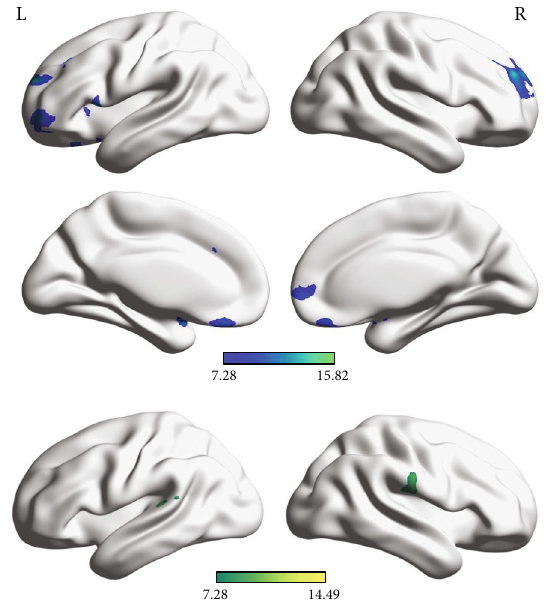
Figure 2: GMV alteration among BD, SZ, and HC. Signi fi cant at p < 0 : 05 with voxel p < 0 : 001 (GRF correction). Blue colour indicates relatively lower GMVs values in both BD and SZ. Green colour indicates relatively lower GMVs values in